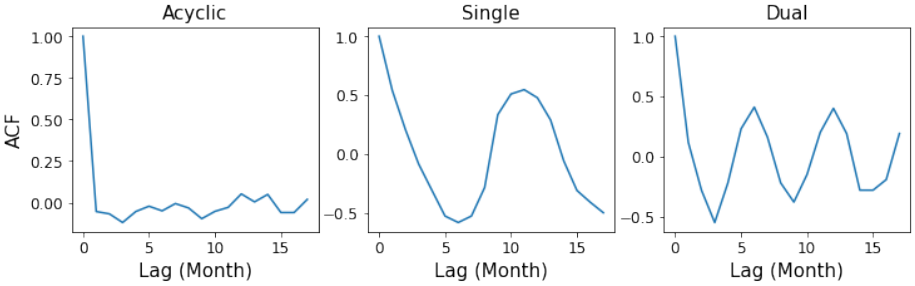
Figure 13. Representative classes of the ACF